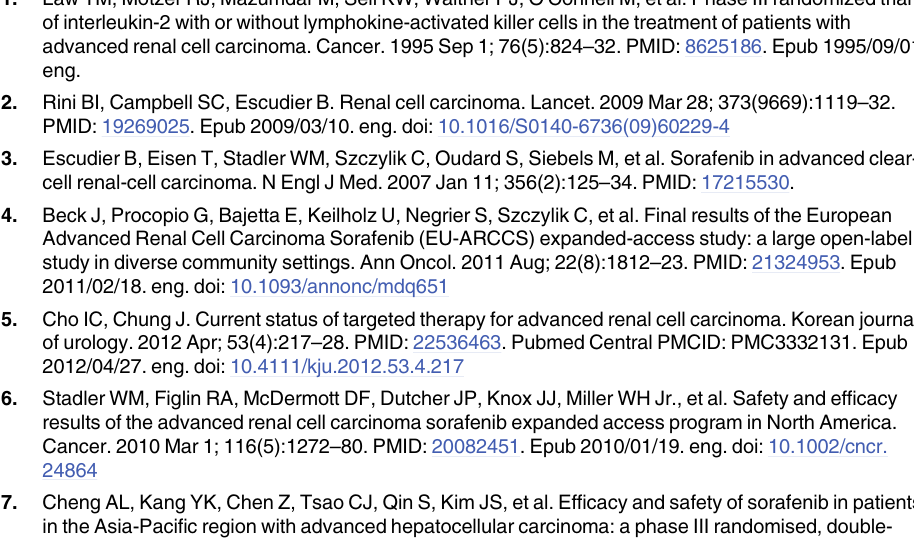
S1 Table. An overall description of adverse events during sorafenib treatment was added in a supplementary